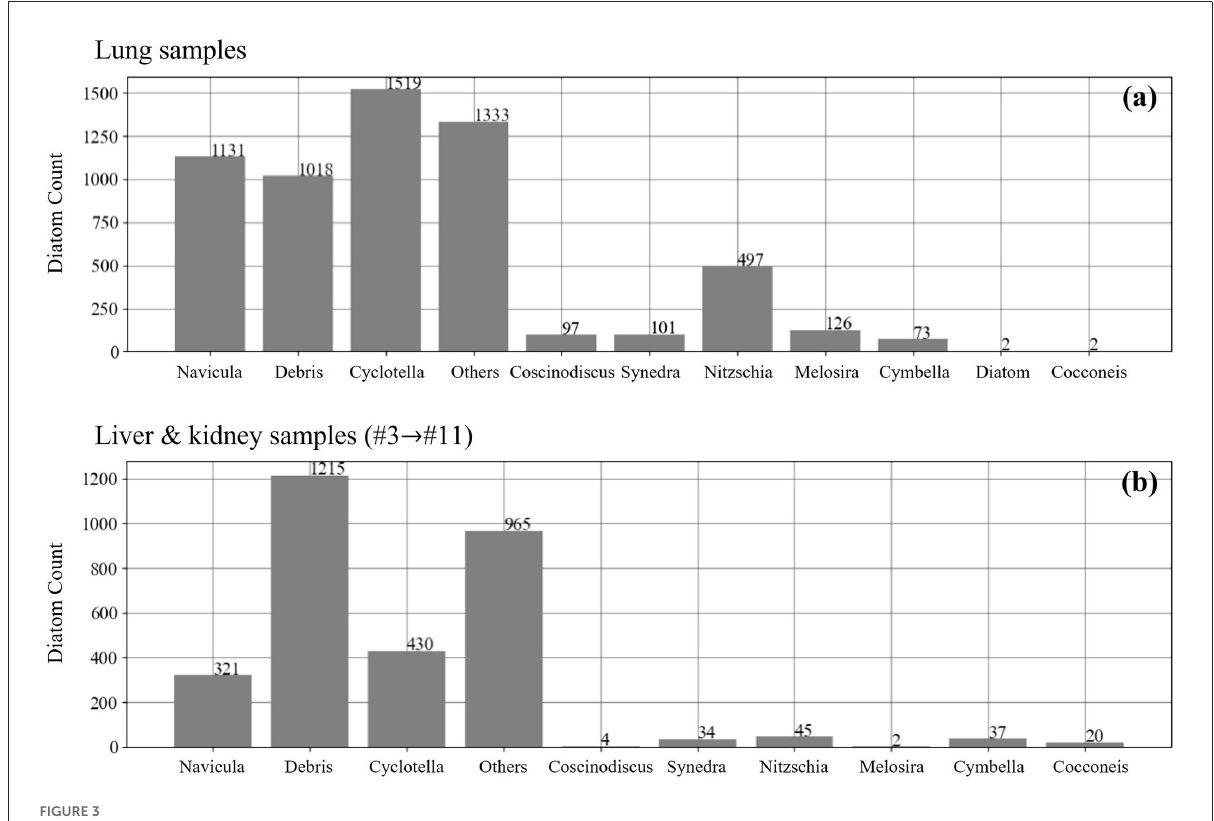
FIGURE3 The number distribution of different diatom genus in the lung (a) , liver and kidney samples (b) .